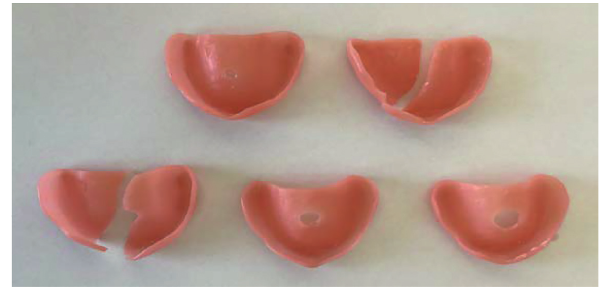
Figure 16: Triplex Hot ® prosthesis bases subjected to pH 7 after fracture.